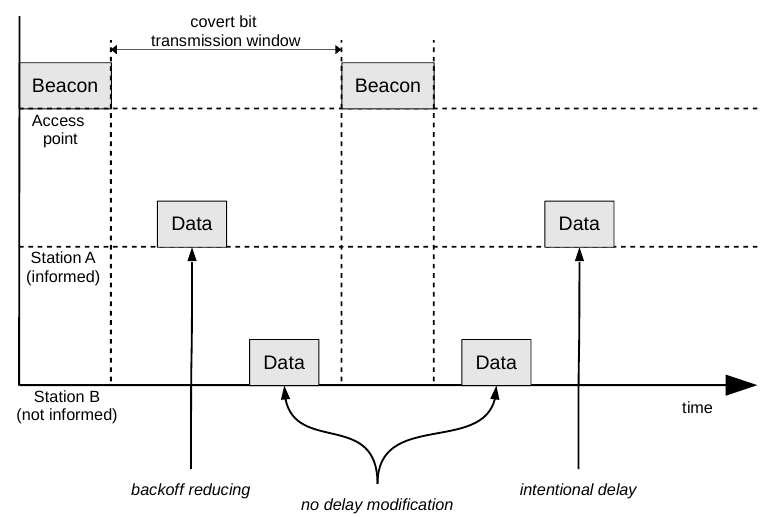
Figure 4. One-informed variant of the SFO